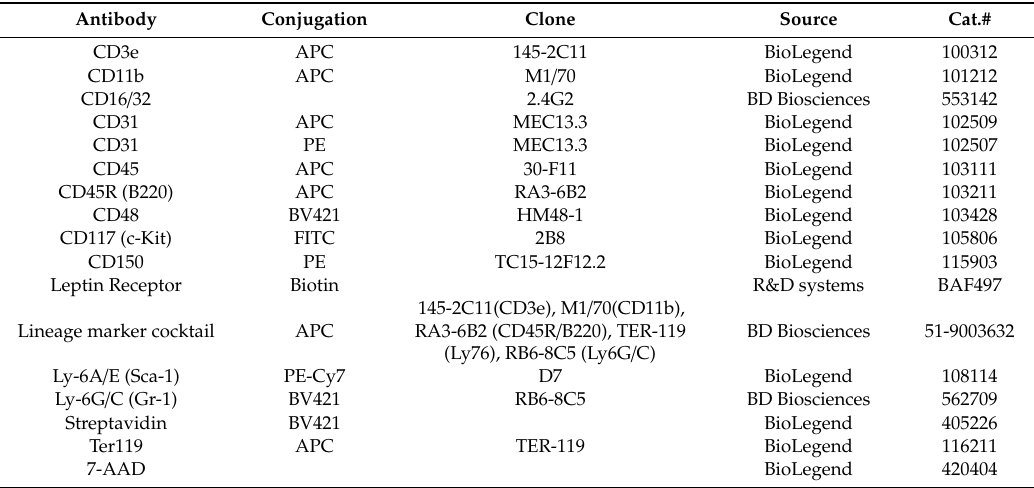
Table 1. Antibodies used for flow